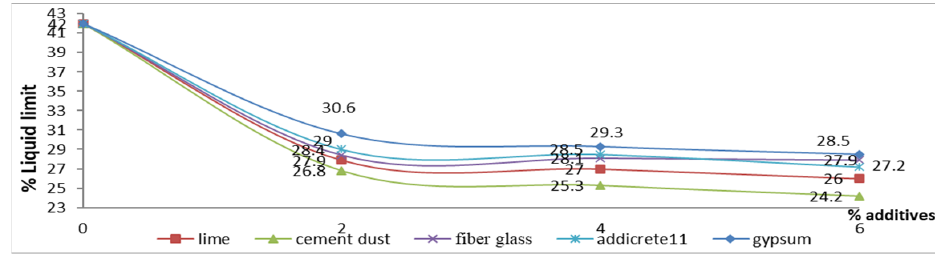
Figure 15. Effects of additives on swelling percentage.